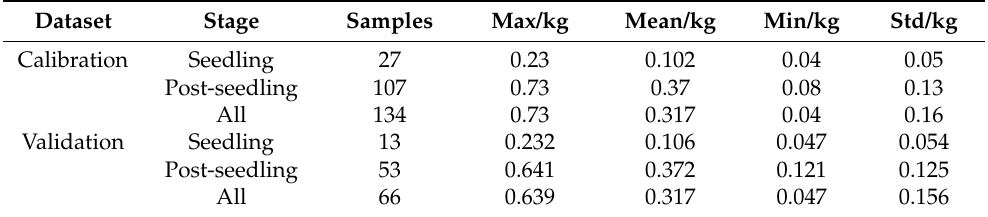
Table 1. Descriptive statistics of aboveground biomass measurements at di ff erent growth stages.